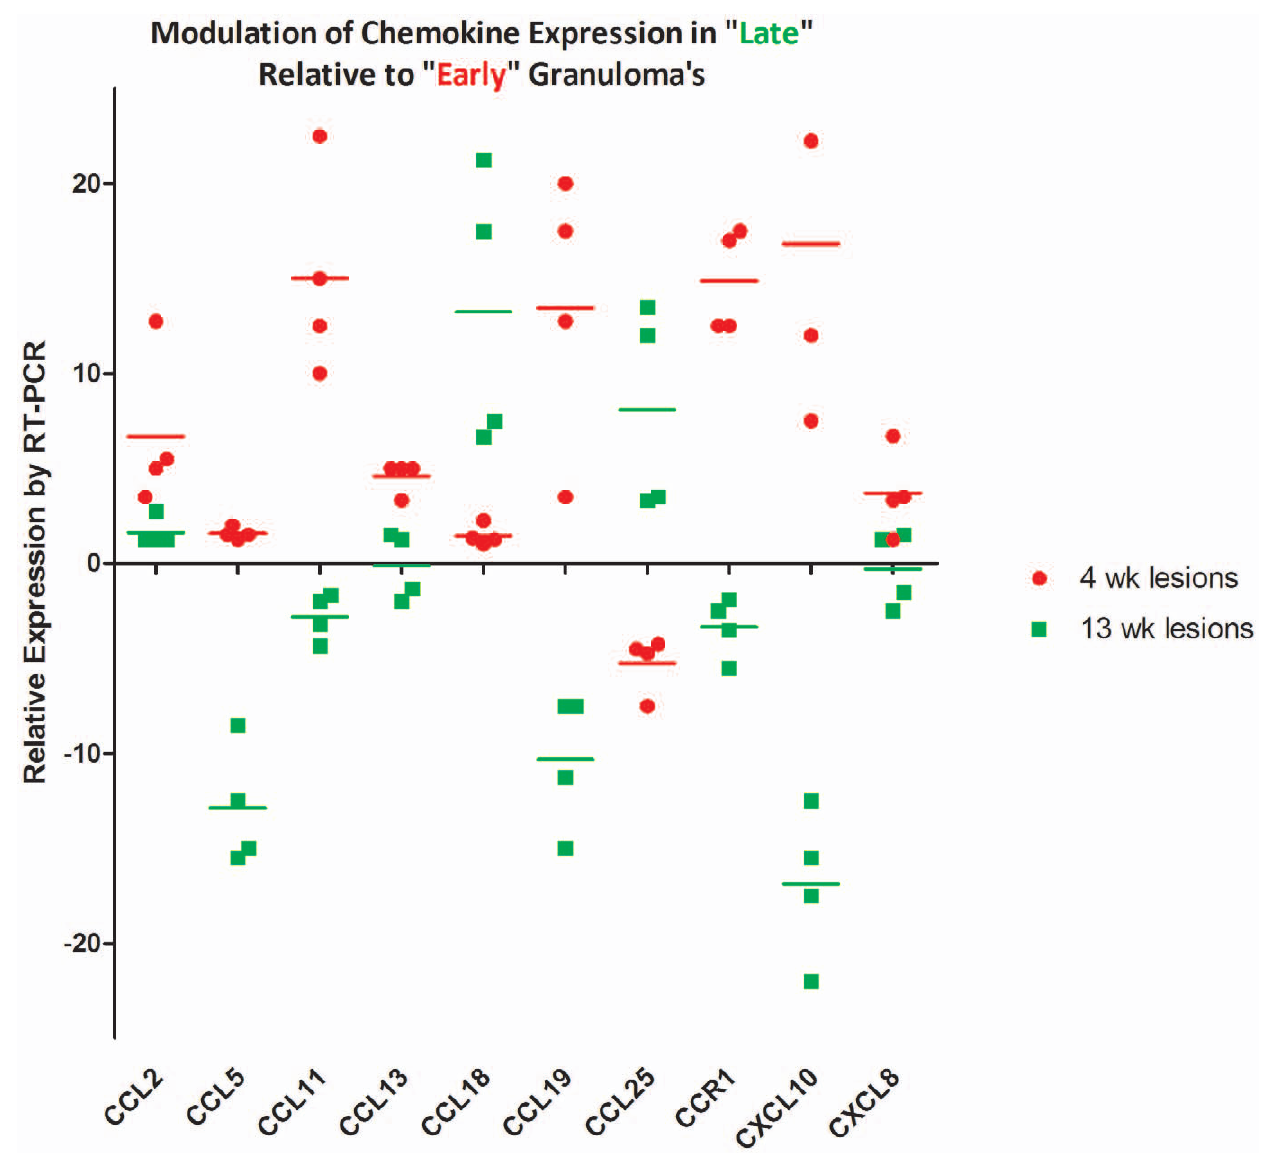
Figure 5. Confirmation of transcriptome results by RT-PCR. Quantitative real-time Reverse-Transcriptase (RT-PCR) arrays specific for chemokines and their receptors were used to confirm microarray results. Biologically independent samples from all three ‘‘early’’ and ‘‘late’’ animals (different from those used in microarray experiment) were pooled into two groups, and duplicate analysis performed using PCR arrays. GAPDH was used as the invariant housekeeping control for normalization. Numeric fold changes reflect the following difference: [Gene x lesion lung (week 4 or week 13) – 18S RNA lesion lung (week 4 or week 13)] – [Gene x normal lung (week 4 or week 13) – 18S RNA lesion lung (week 4 or week 13)]. The expression of CCL25 was checked by conventional SyBr green RT-PCR, using the Applied Biosystems (Foster City, CA) Fast SYBR Green kit since it was not included in the PCR array. Data was analyzed in a manner comparable to PCR-arrays.